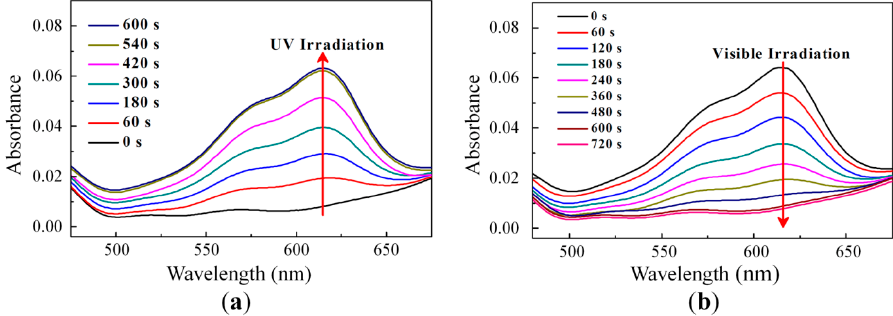
Figure 3. Absorption spectrum variation ( a ) under UV light irradiation; and ( b ) under visible light irradiation.